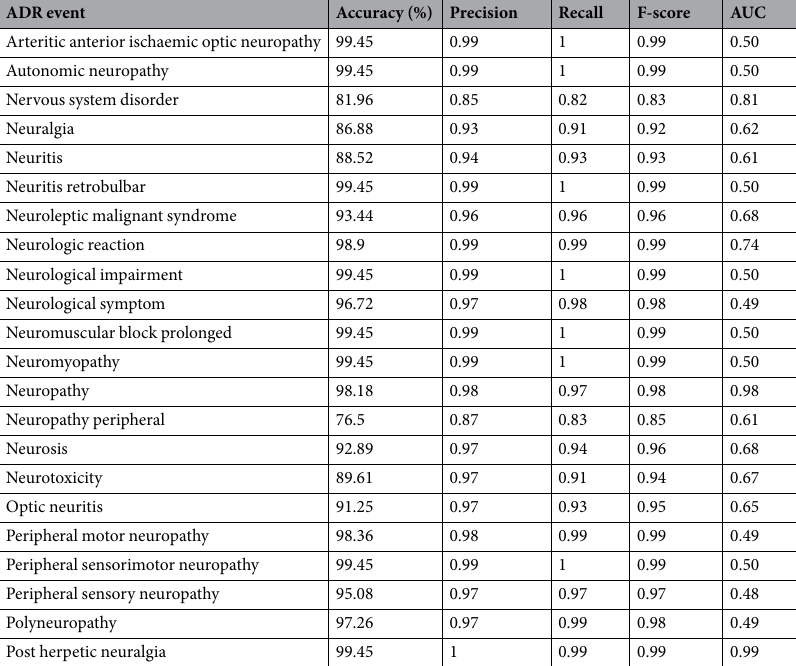
Table 6. Provides the performances of the models generated using the Chemical + Phenotypic